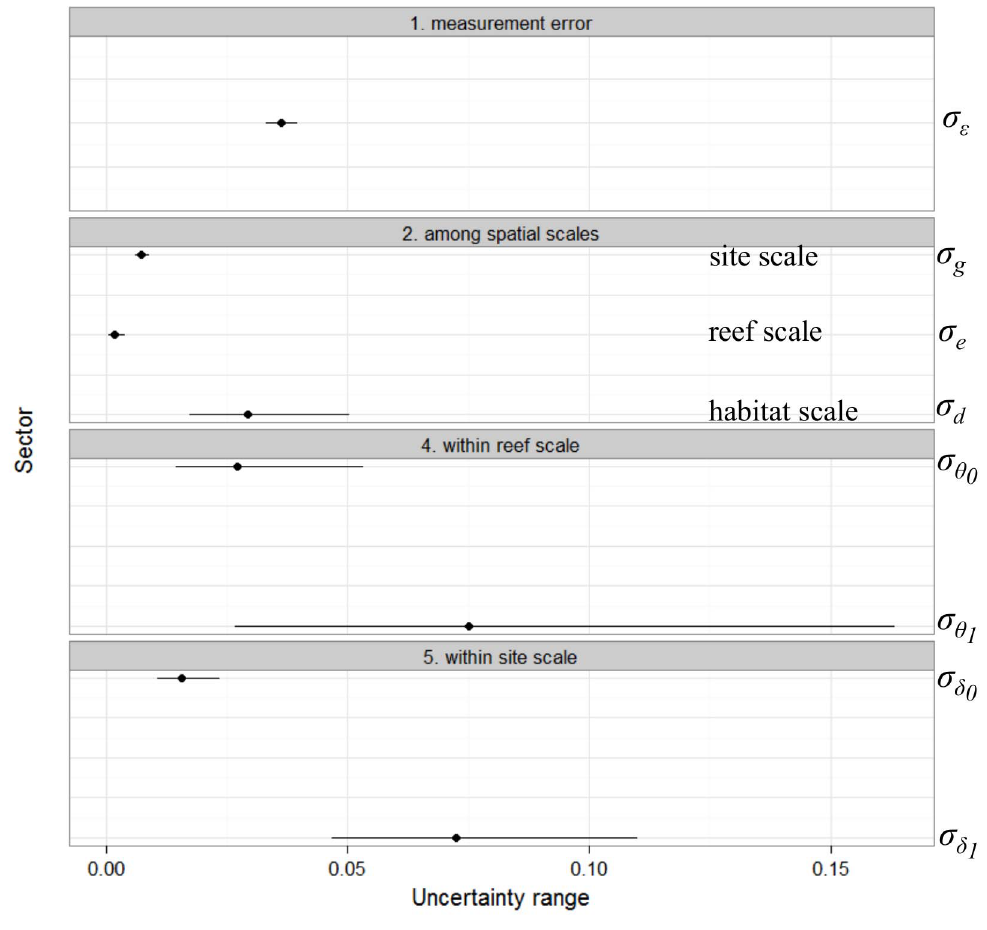
Figure 4. Estimation of the uncertainty in the three hierarchical stages of the model. The measurement error s e corresponds to the uncertainty at the data stage, and all other variance components s account for uncertainty in the process model, decomposed into the variability in trend (intercept and slope) of coral cover at the three spatial scales of habitat, reefs and sites.